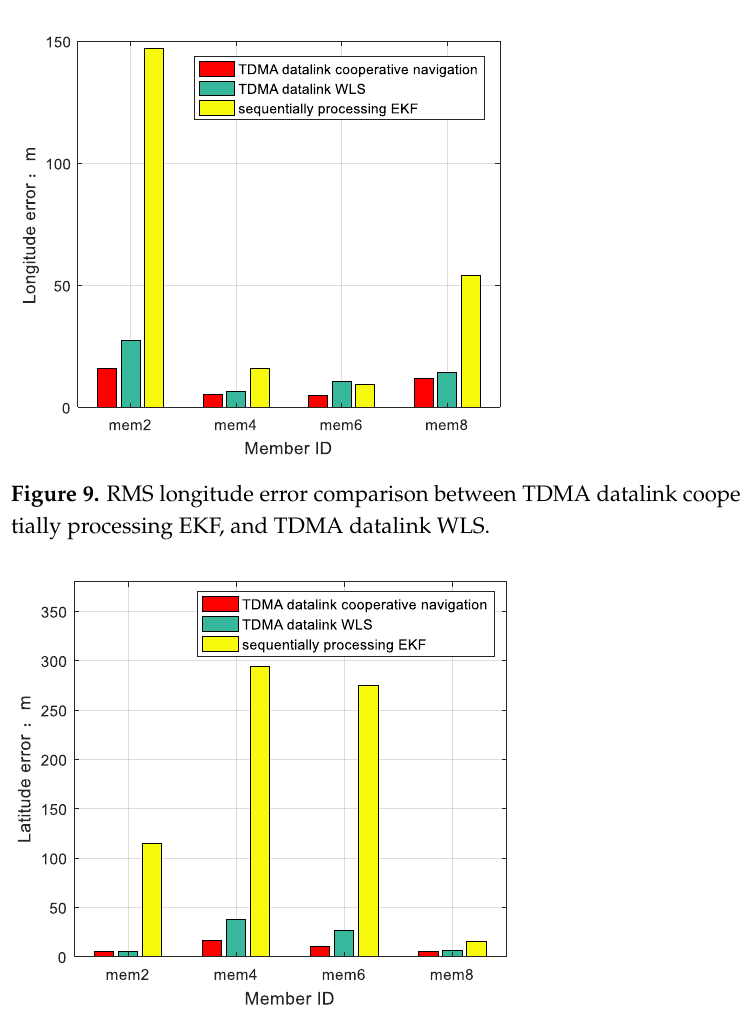
Figure 10. RMS latitude error comparison between TDMA datalink cooperative navigation, sequen- tially processing EKF, and TDMA datalink WLS.